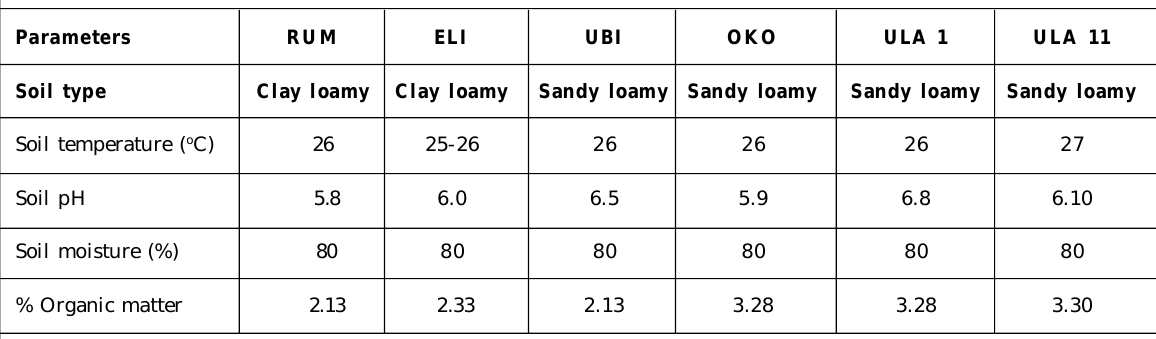
Table 3: Soil physic-chemical parameters analysis of soil in the study areas